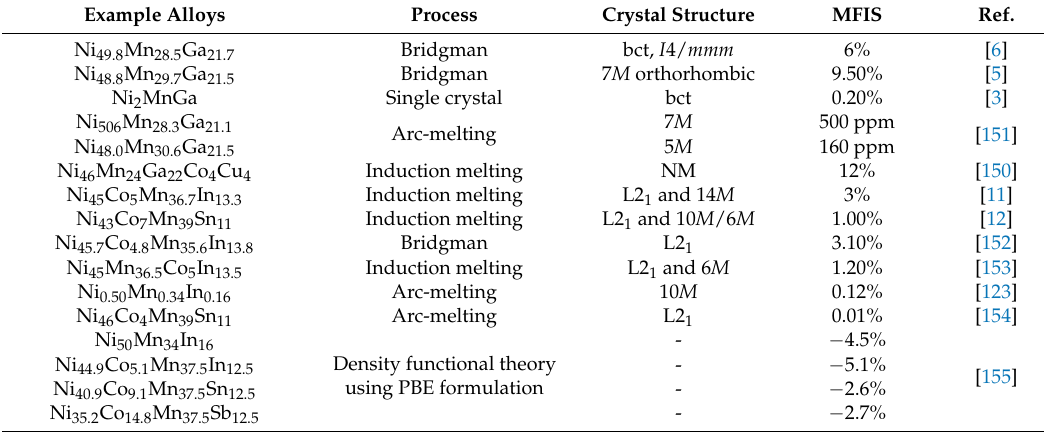
Table 1. Crystal structure and magnetic field-induced strain (MFIS) in magnetic/metamagnetic shape memory (MSM/MMSM) alloys retrieved from literature.